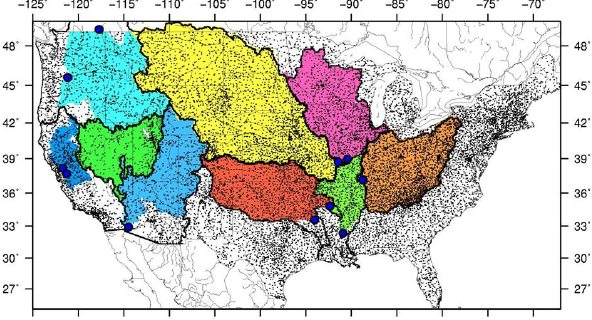
Fig. 1. Large-scale study domain, including precipitation gauges (black dots), as well as major hydrologic regions (shaded) that are defined through their drainage at stream gauges (blue circles). The un-shaded areas within these regions are either downstream of the stream gauge, or consist of many smaller river basins which drain directly into the Atlantic or Pacific Oceans or the Gulf of